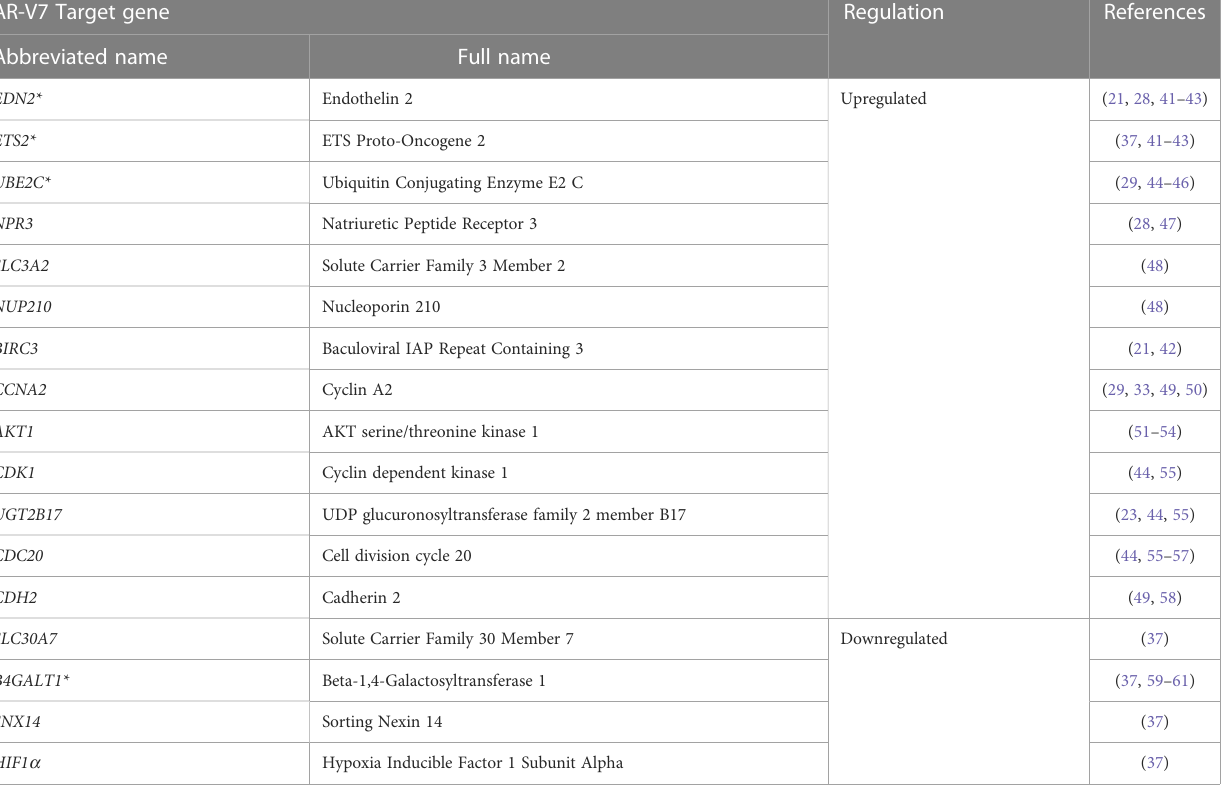
TABLE 1 Summary of AR-V7 target genes de fi ned in the literature. AR-V7 Target